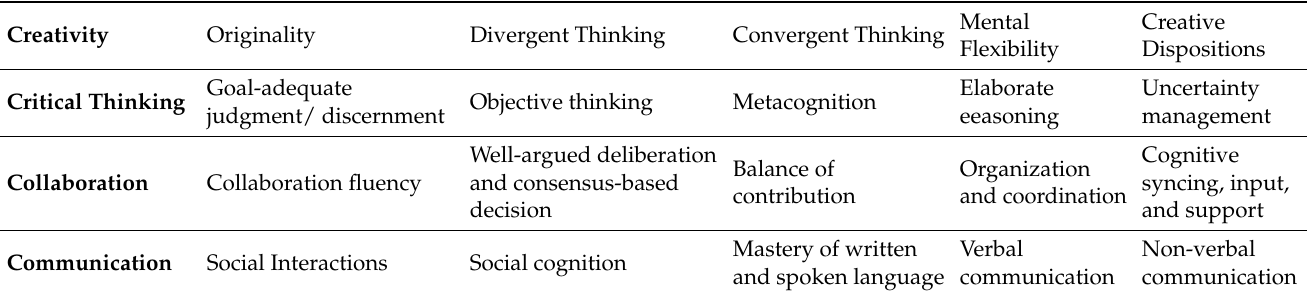
Table 3. Five different components evaluated for each C by the 4Cs assessment framework for